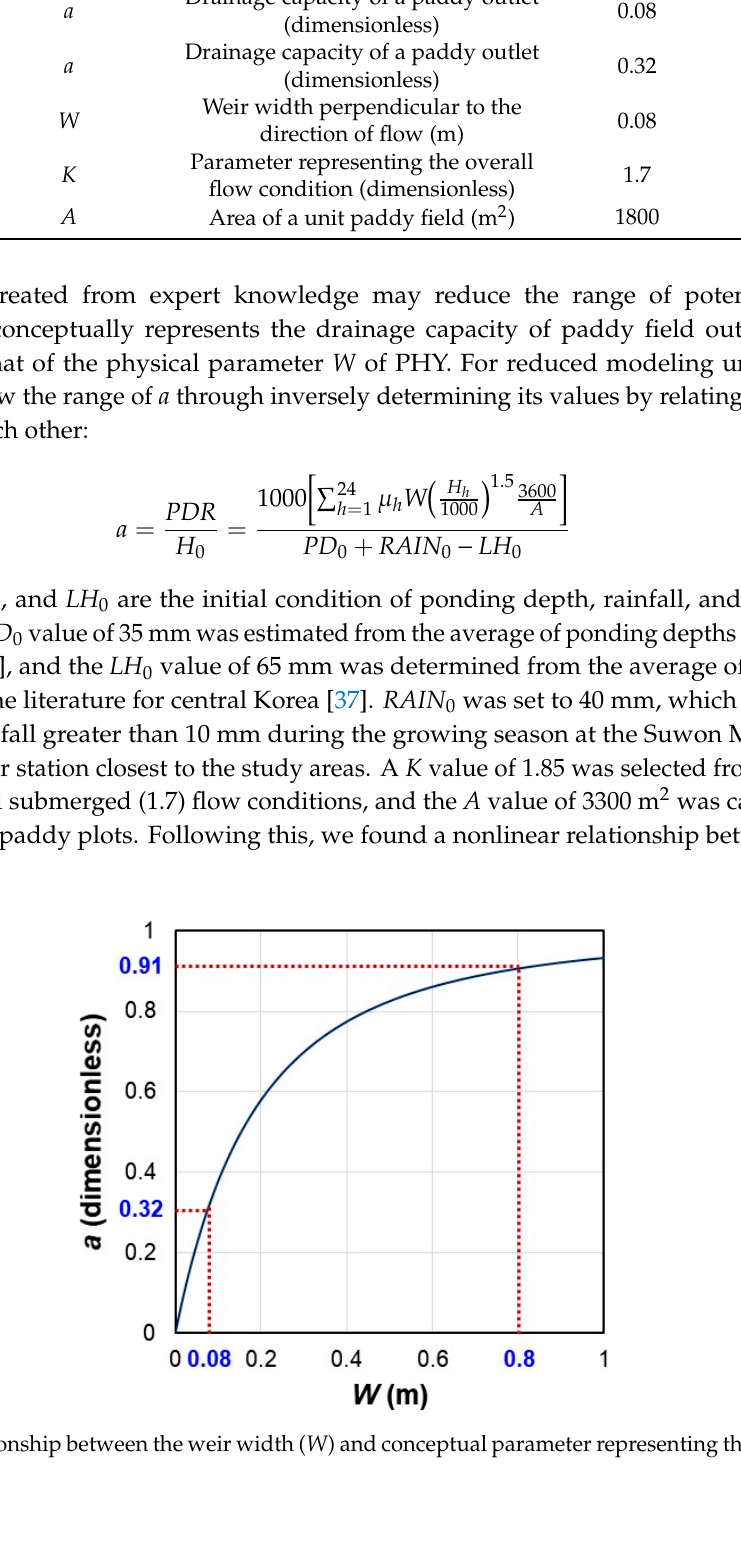
Table 3. Parameter value ranges of the conceptual (CON) and physically-based (PHY) approaches. Scheme